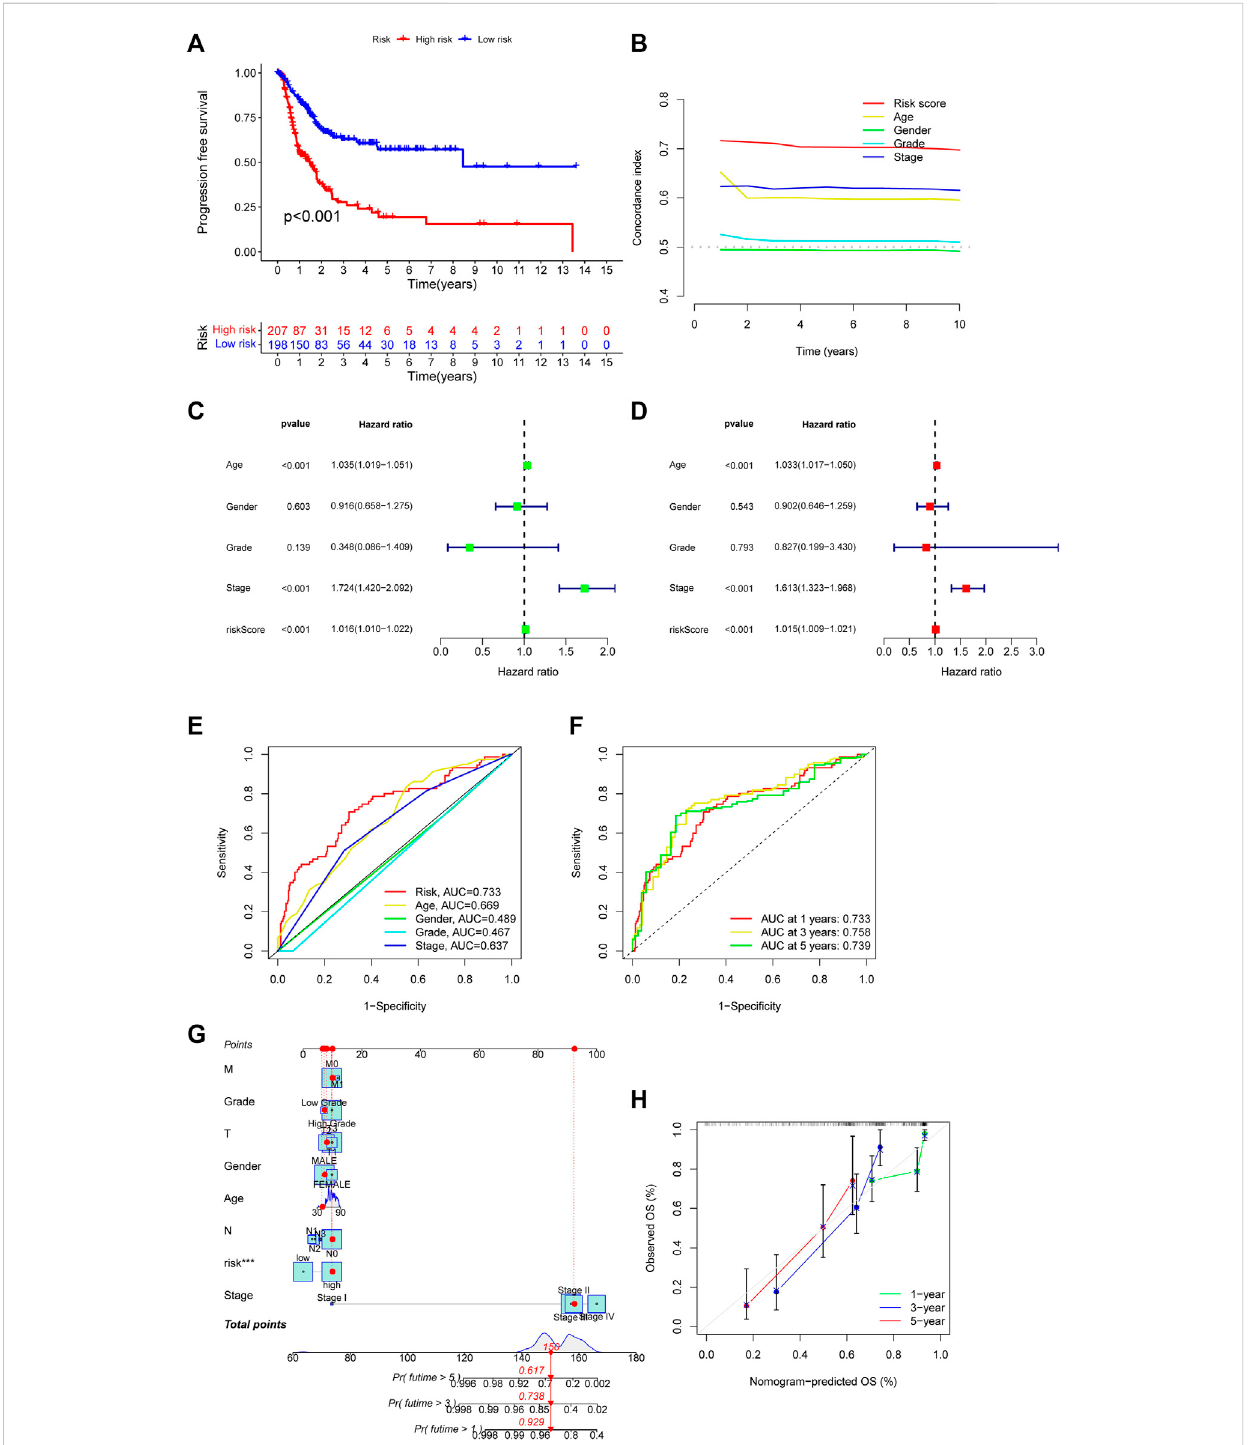
FIGURE 4 Evaluation of CupRLSig model predictive accuracy using the all TCGA-BLCA group (A) Kaplan – Meier curves for progression-free survival of BLCA patients (B) C-index curve of the risk model depicts risk scores and other clinical parameters that predict BLCA patients ’ prognosis (C) Forest plots for univariate Cox proportional-hazard analysis (D) Forest plots for multivariate Cox proportional-hazard analysis (E) ROC curve of the CupRLSig risk score andotherclinicopathologicalvariables (F) Time-dependentROC curves for1-,3-, and5-year survivalfor theCupRLSig (G) A nomogram combining clinicopathological parameters and risk scores predicts 1-, 3-, and 5- year survival probabilities of BLCA patients (H) Calibration curves assess the agreement between actual and predicted overall survival at 1-, 3-, and 5-